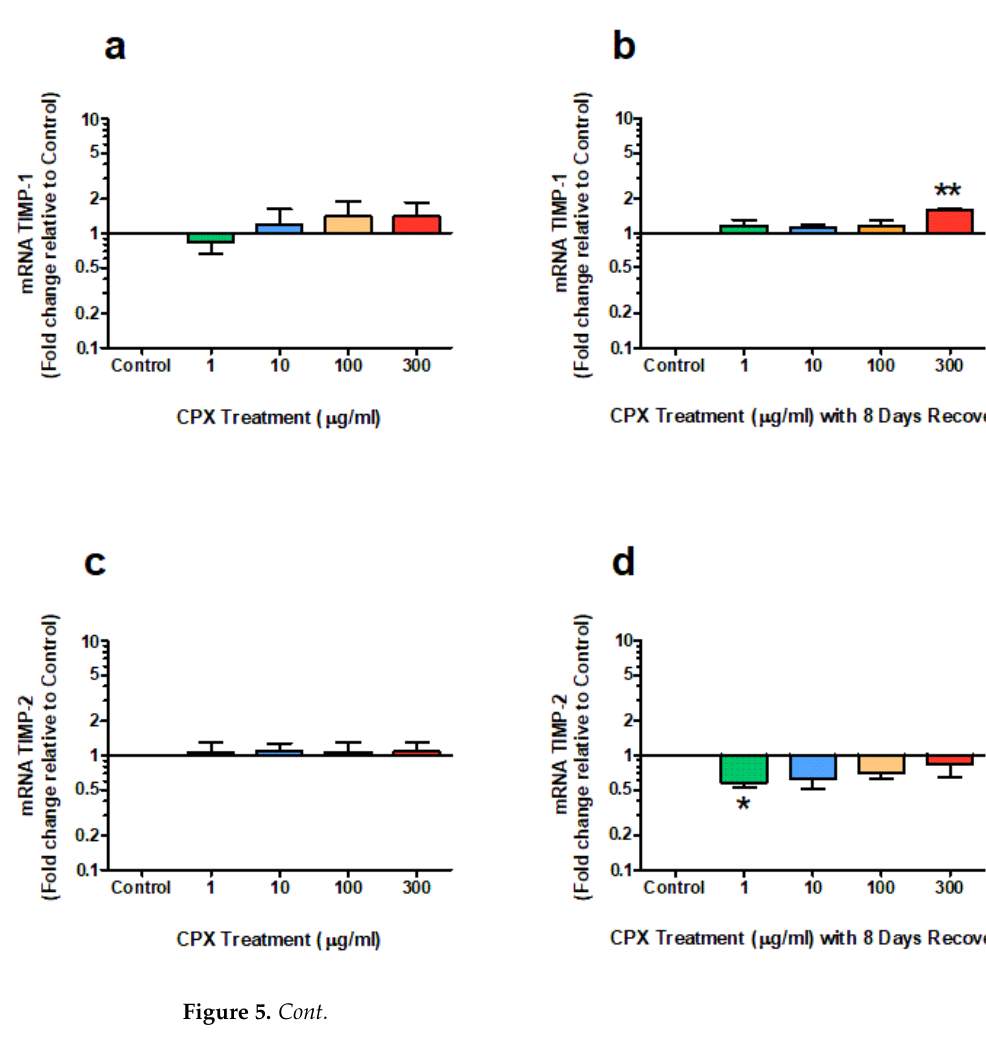
Figure 5. m RNA expression of TIMP-1 ( a , b ), TIMP-2 ( c , d ) and TIMP-3 ( e , f ) after 4 days treatment with 1, 10, 100 & 300 µg/mL CPX and subsequent 8-day recovery period in equine derived tendon explant cultures (n = 4). Results are expressed logarithmically. Values represent mean ± SEM and are expressed as fold change relative to control, normalised to GAPDH. * p < 0.05, ** p < 0.01 vs. control.